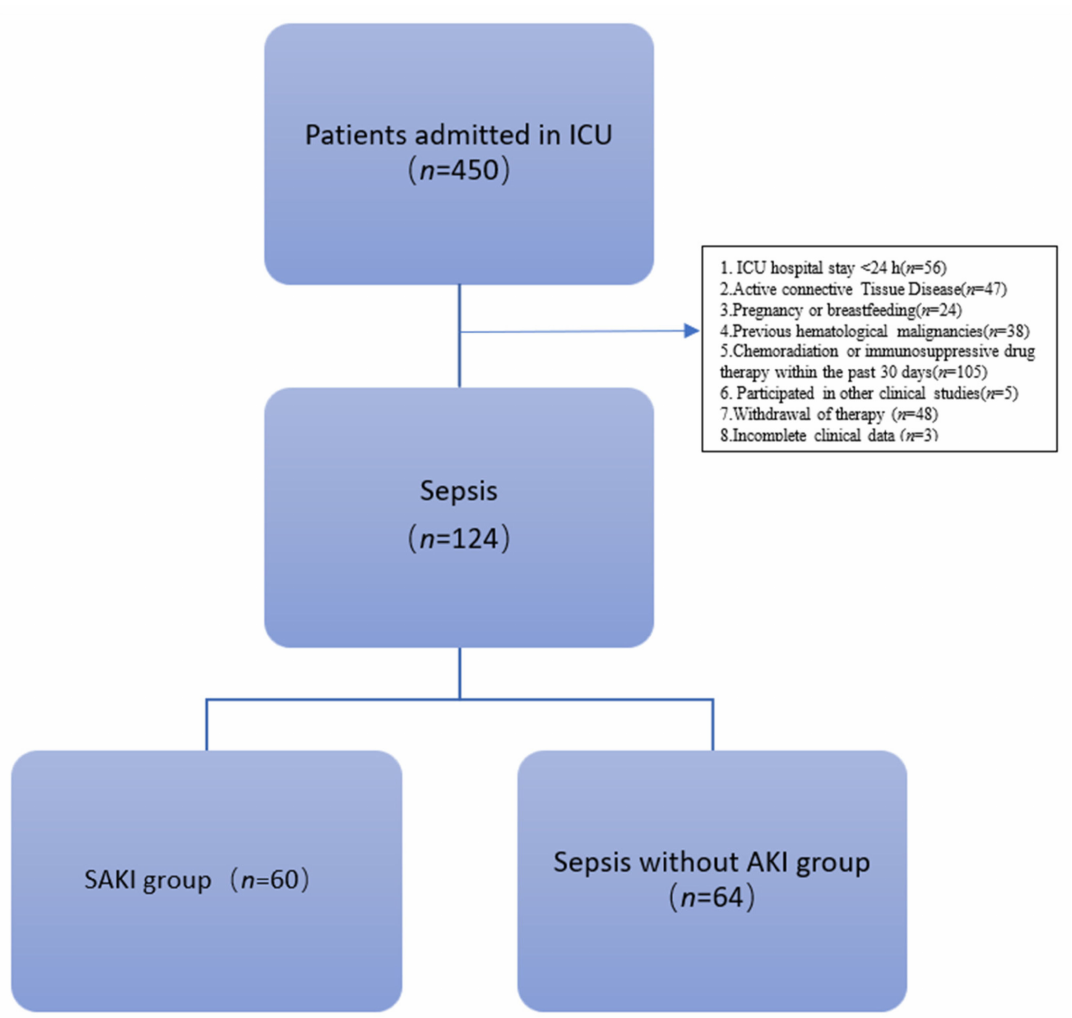
Figure 1. Study flow chart. SAKI: sepsis-induced acute kidney injury; AKI, acute kidney injury; ICU, intensive care unit.